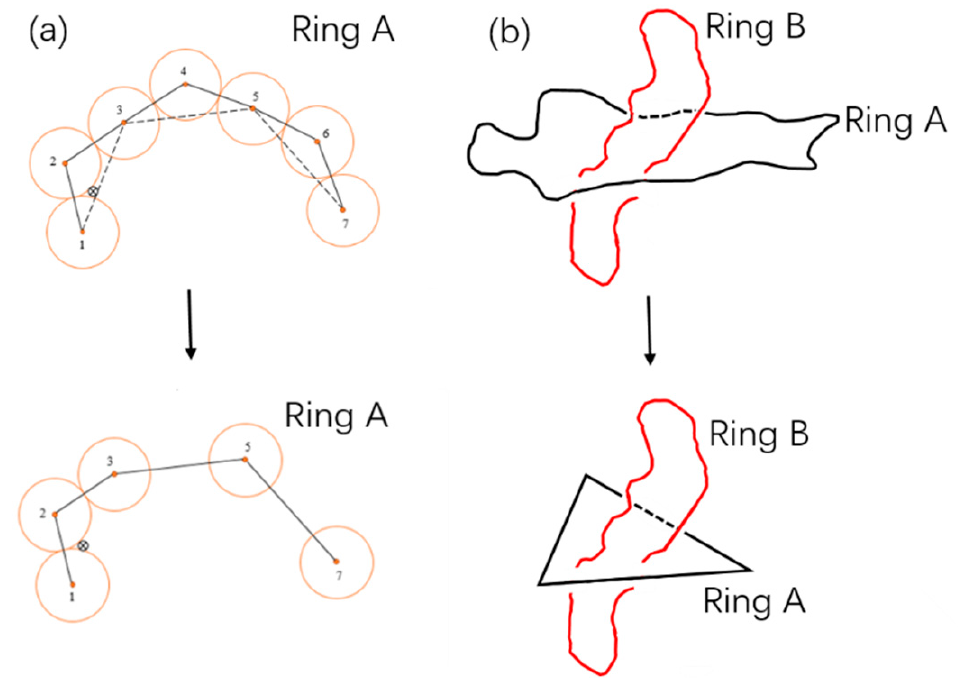
Figure 2. ( a ) Illustration of the KMT algorithm [38–40]. Ring A is passively threaded by ring B, which is omitted for simplicity with only one dot marking a cross bond. Monomers 1~7 are part of the ring A. After the first reduction, monomers 4 and 6 are removed as triangle 345 and 567 are not intersected by Ring B. ( b ) If the ring A is threaded by ring B, ring A can be reduced finally into a triangle after many KMT